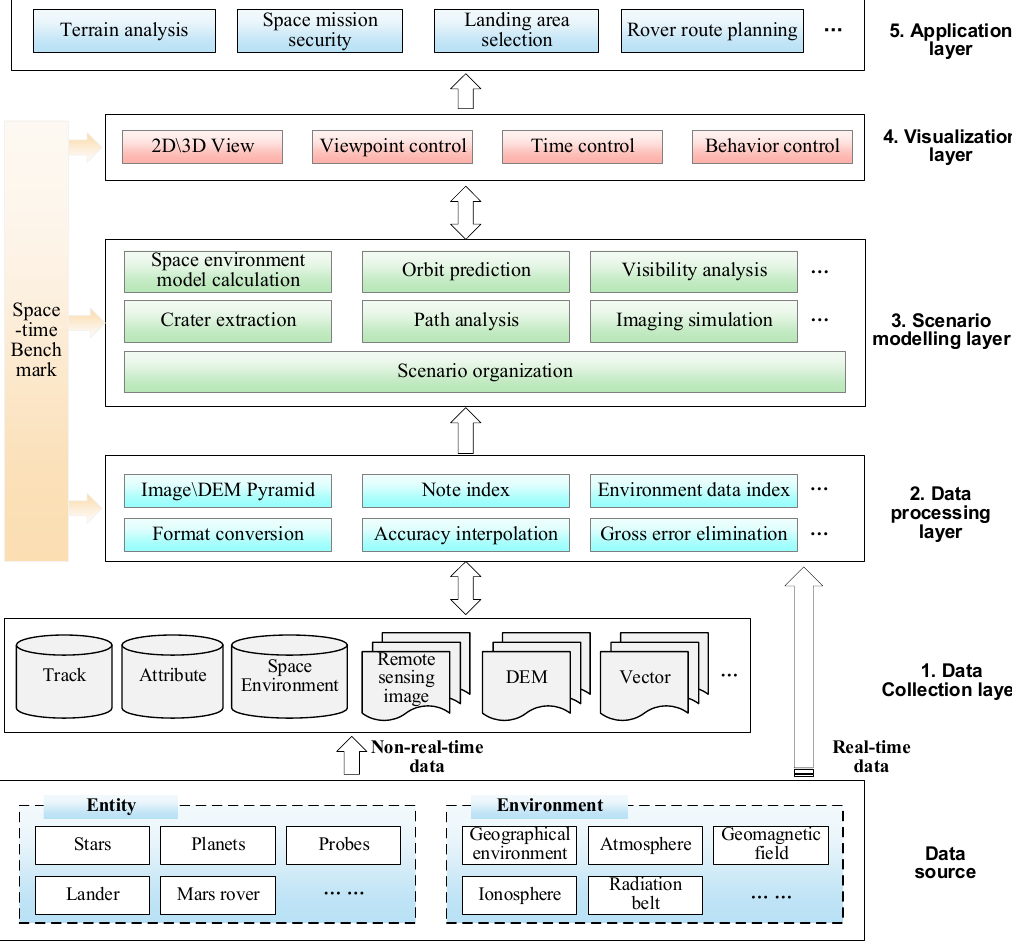
Figure 5. Overview of the Sino-Mars